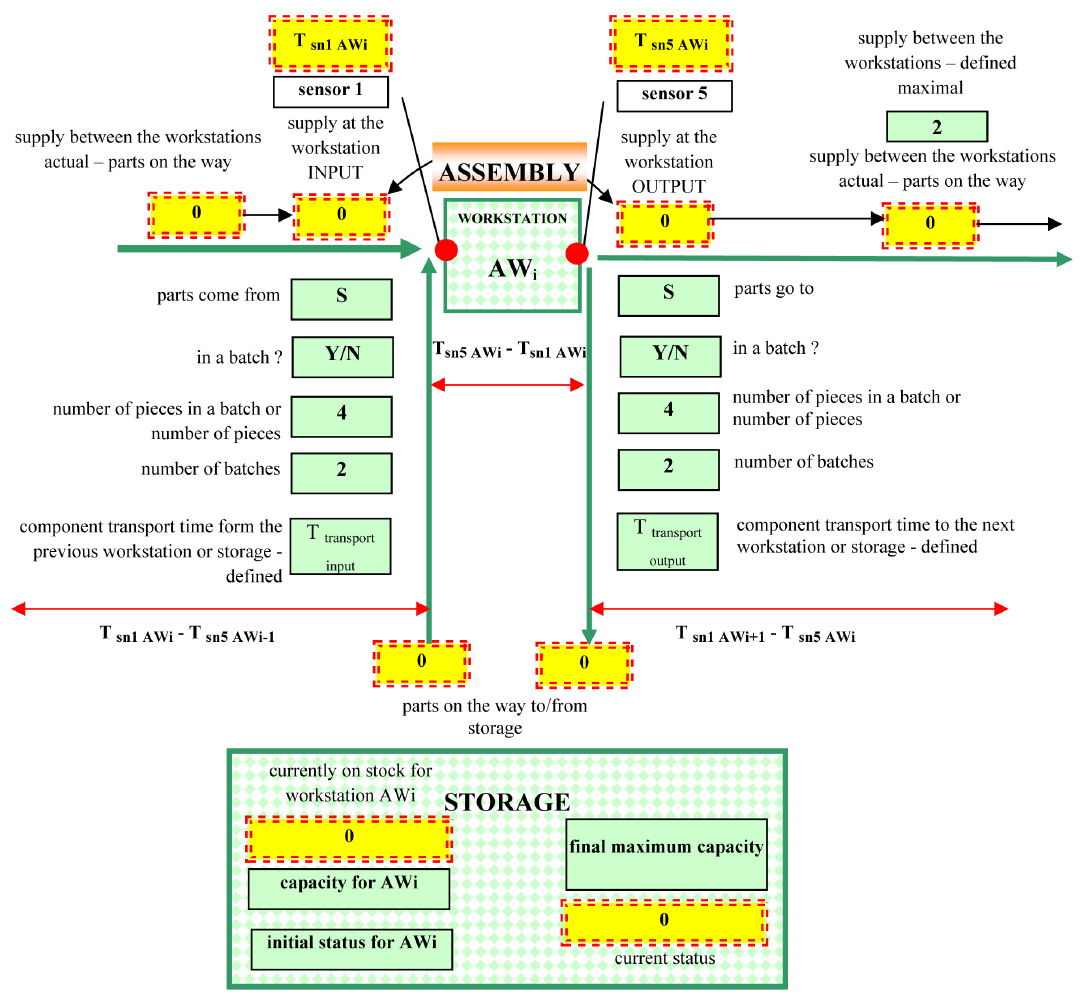
Figure 3: Chart of complete data of the on-line analysis model.